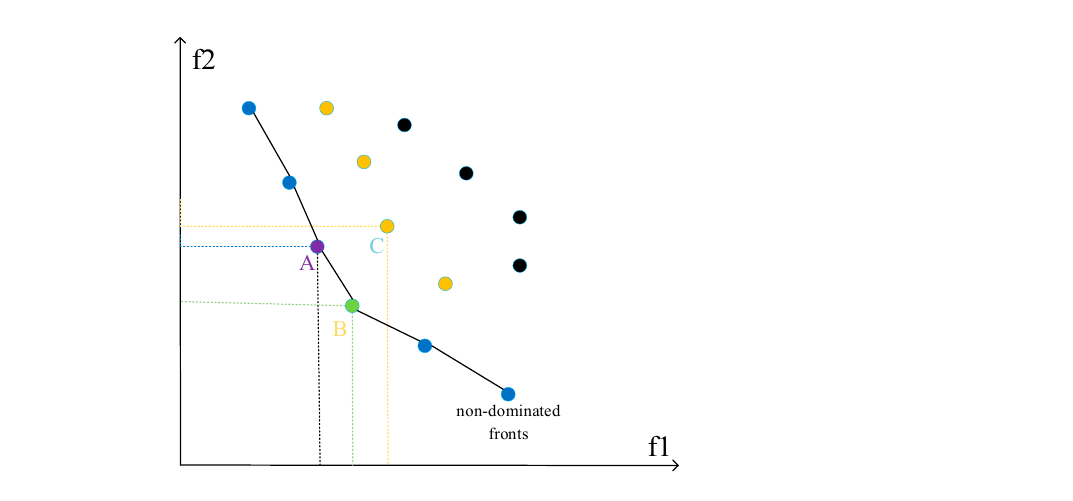
Figure 3. Diagram of non-dominated fronts. The letters A, B and C represent the solution A, B and C. Points of the same color represent solutions in the same dominance